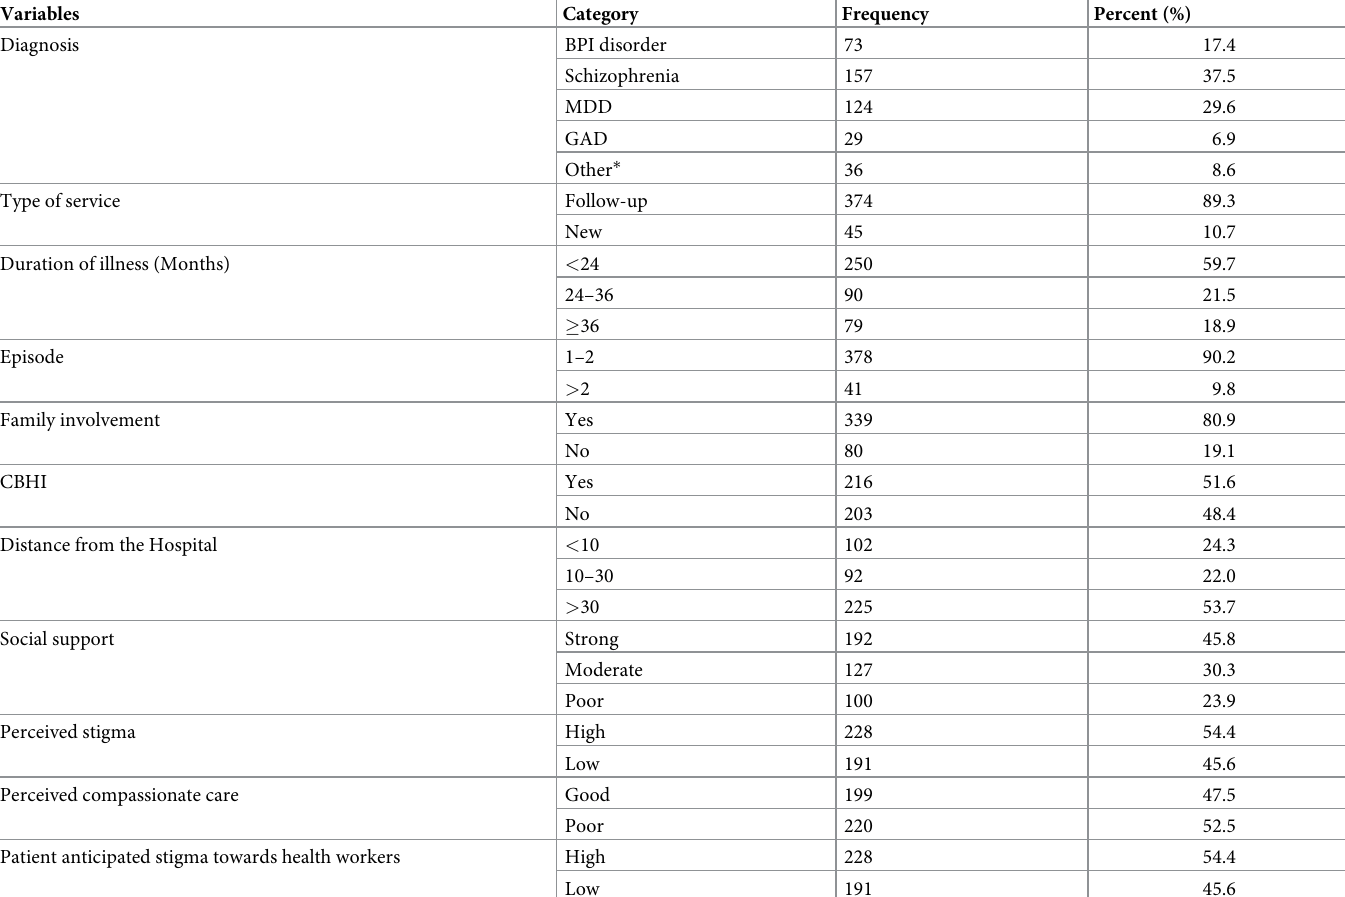
Table 2. Clinical, social, and service related characteristics of respondent’s care among patients with mental illness at TGSH and FHCSH, North West, Ethiopia, 2022 (n =